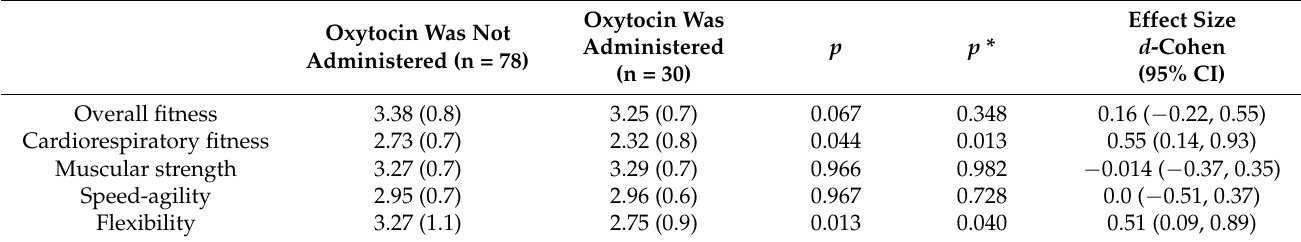
Table 3. Differences in the self-reported physical fitness components of the pregnant women at the 34th gestational week by oxytocin administration before or during